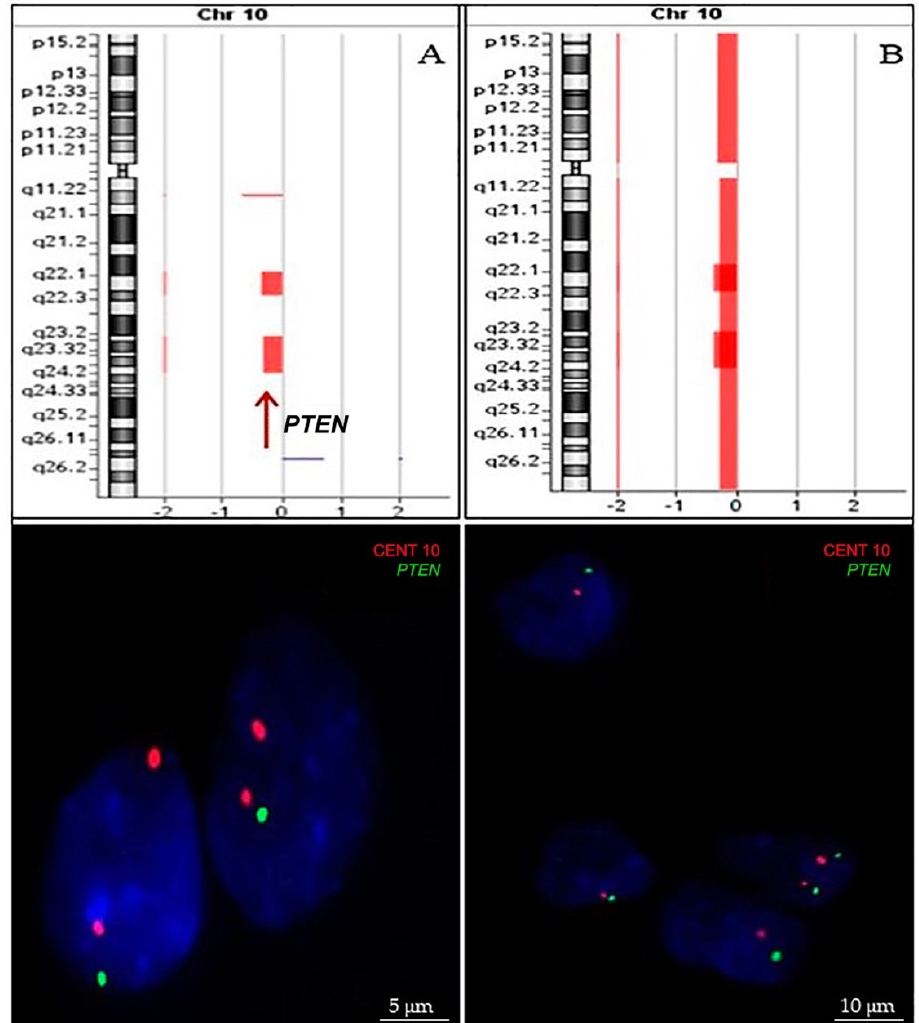
Figure 4. PTEN allelic loss identified by array-CGH (upper line) was confirmed by iFISH using LSPs (lower line). Results for two exemplary cases are shown: Image ( A ) shows heterozygous deletion of PTEN gene; image ( B ) shows monosomy of chromosome 10.